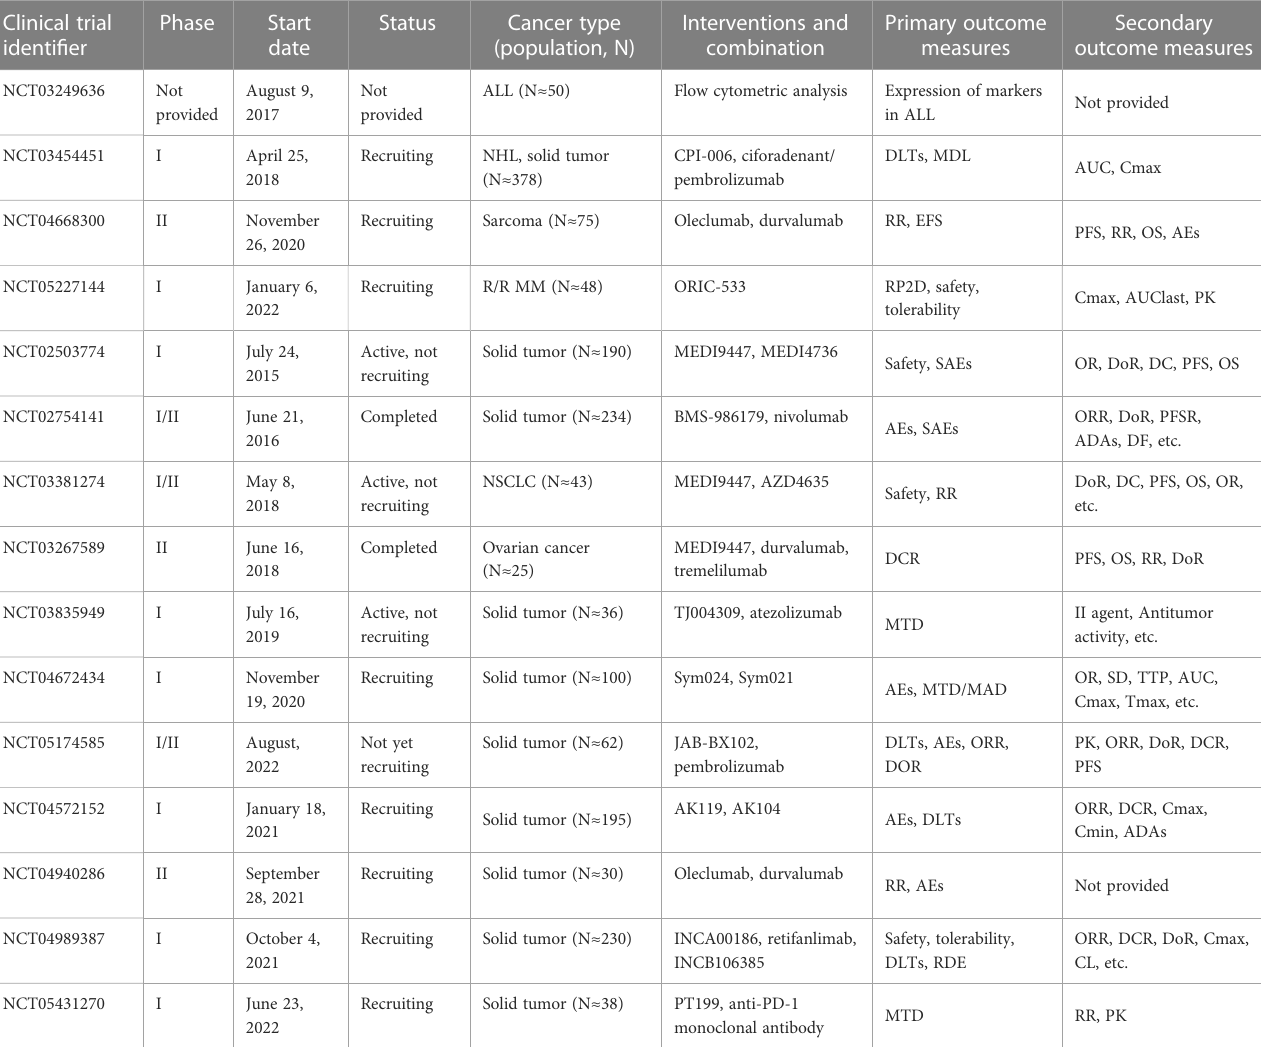
TABLE 2 Antagonists of CD73 currently in clinical